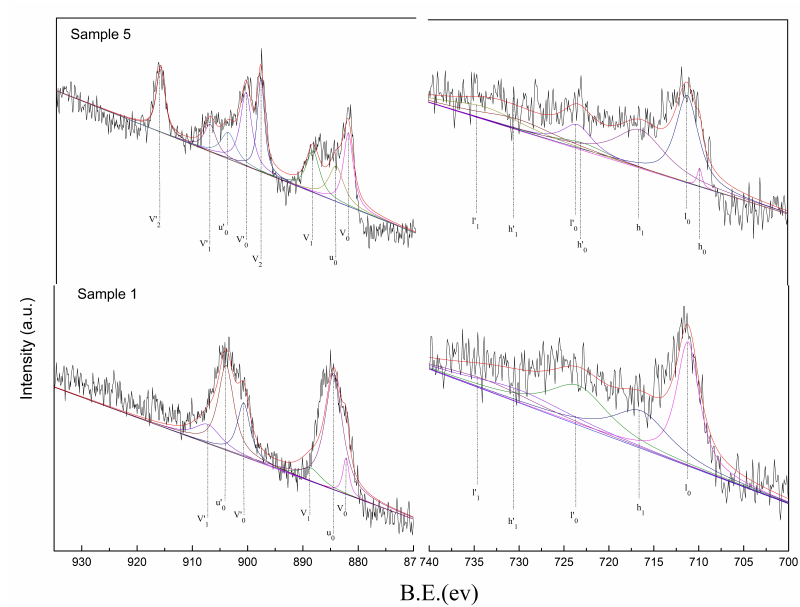
Figure 3. XPS energy spectrum of Ce and Fe 2p orbital on the surface of ore and acid-base co-processed active